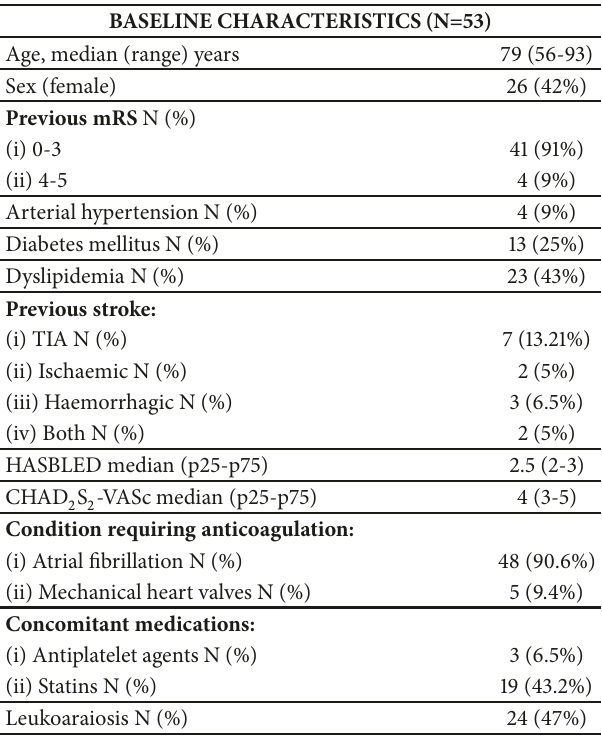
Table 1: Baseline